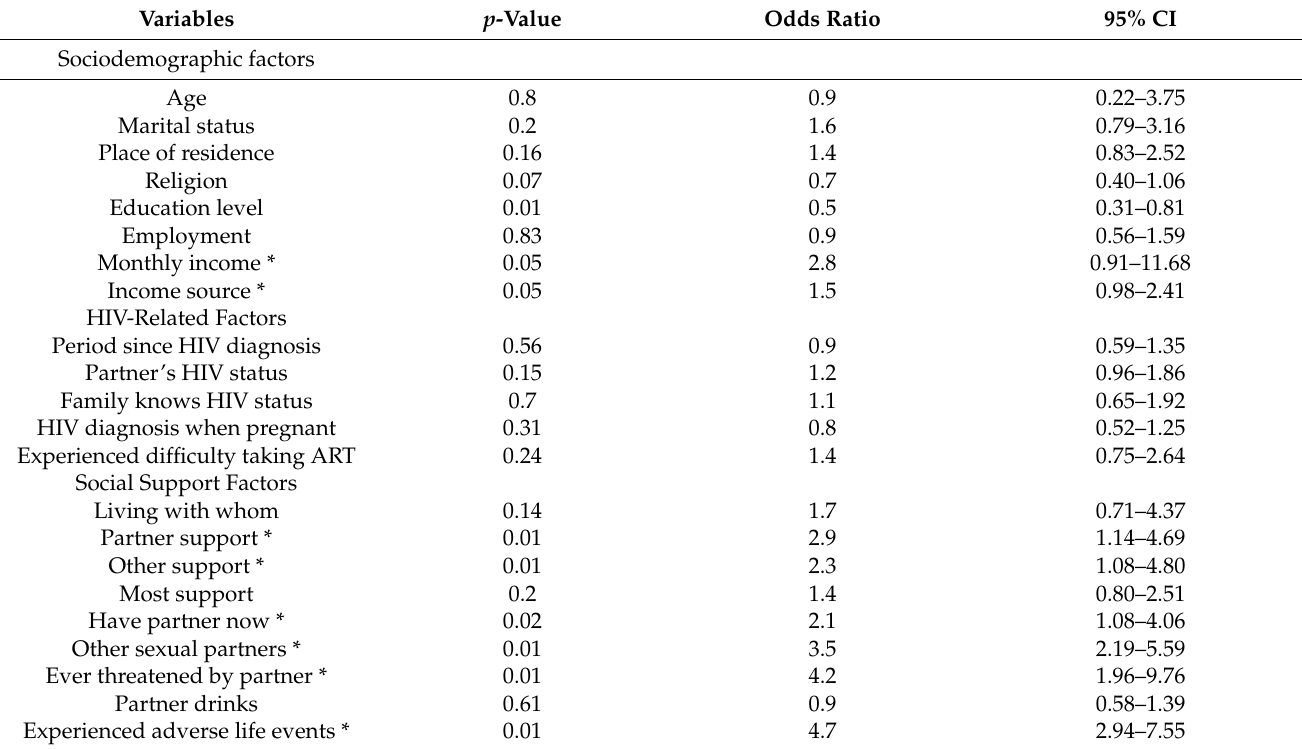
Table 5. Bivariate analysis of factors associated with